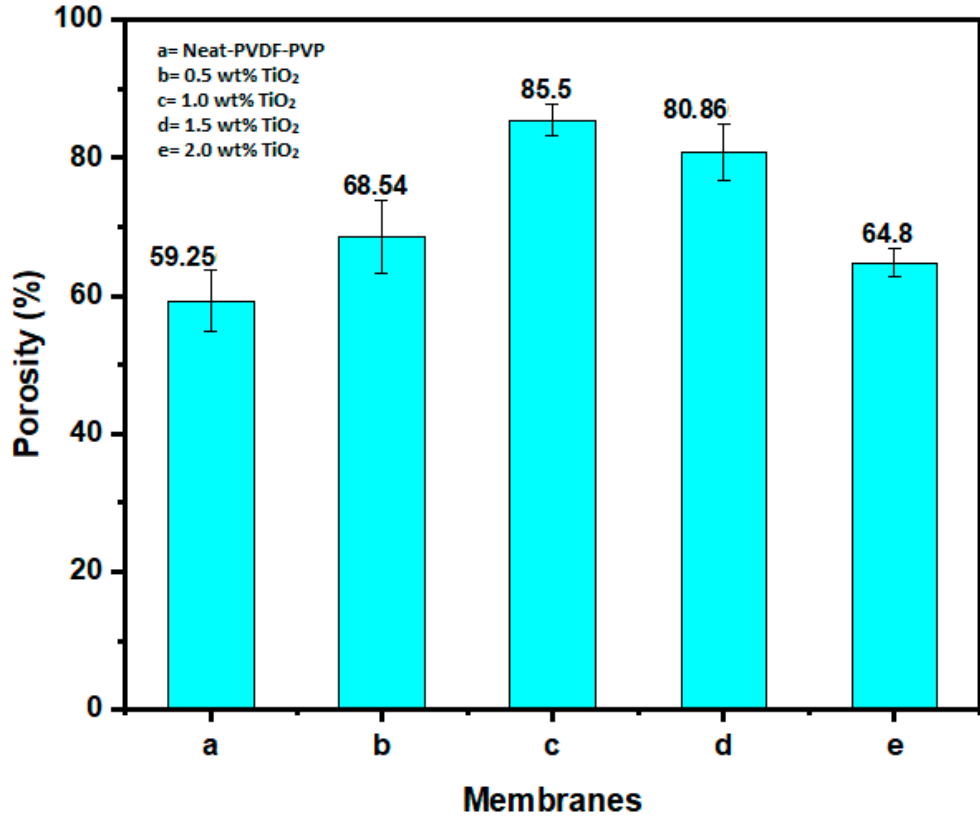
Figure 4. Porosity of neat PVDF-PVP ( a ) and nano-hybrid membranes modified with TiO 2 ( b – e ).